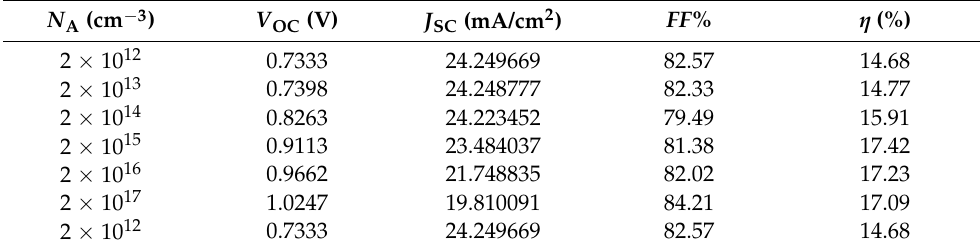
Table 5. Effectiveness of the acceptor carrier concentration ( N A ) on the electrical cell performance parameters at T = 300 K.